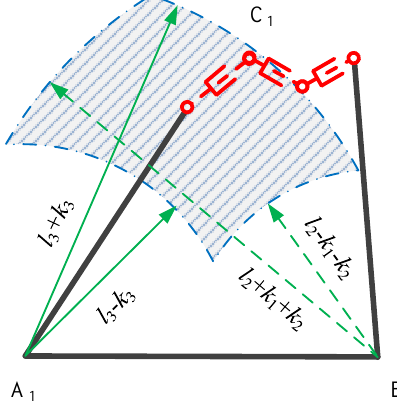
Figure 7. Workspace of point C 1